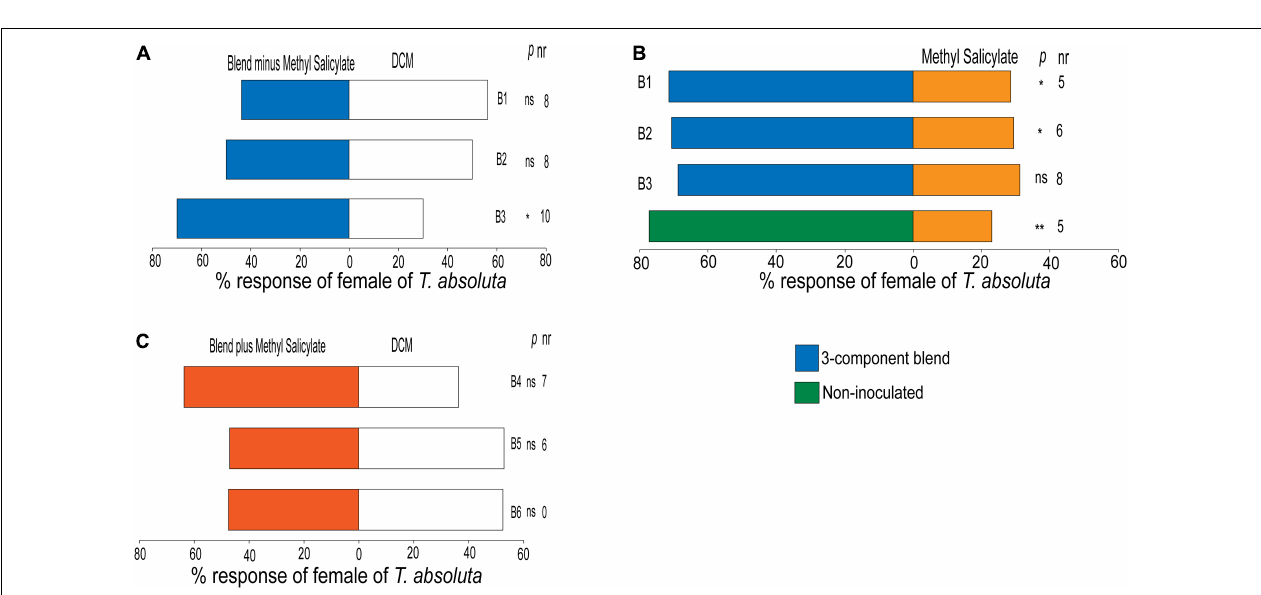
FIGURE 5 | Behavioral responses of females of Tuta absoluta to odor components tested at three concentrations (A) α -pinene, (B) 2-carene, (C) β -phellandrene, (D) ( E )- β -caryophyllene, and (E) methyl salicylate, all against DCM, dichloromethane (control solvent) in a Y-tube olfactometer. Each pair of evaluation used a total of n = 40 females of Tuta absoluta for each compound concentration released singly per choice. nr, number of non-respondent insects (i.e., no choice). P stands for statistical significance levels with ns, no significant difference ( P > 0.05); *, ***, significant differences at P < 0.05 and P < 0.001, respectively, from χ 2 test at α = 0.05.